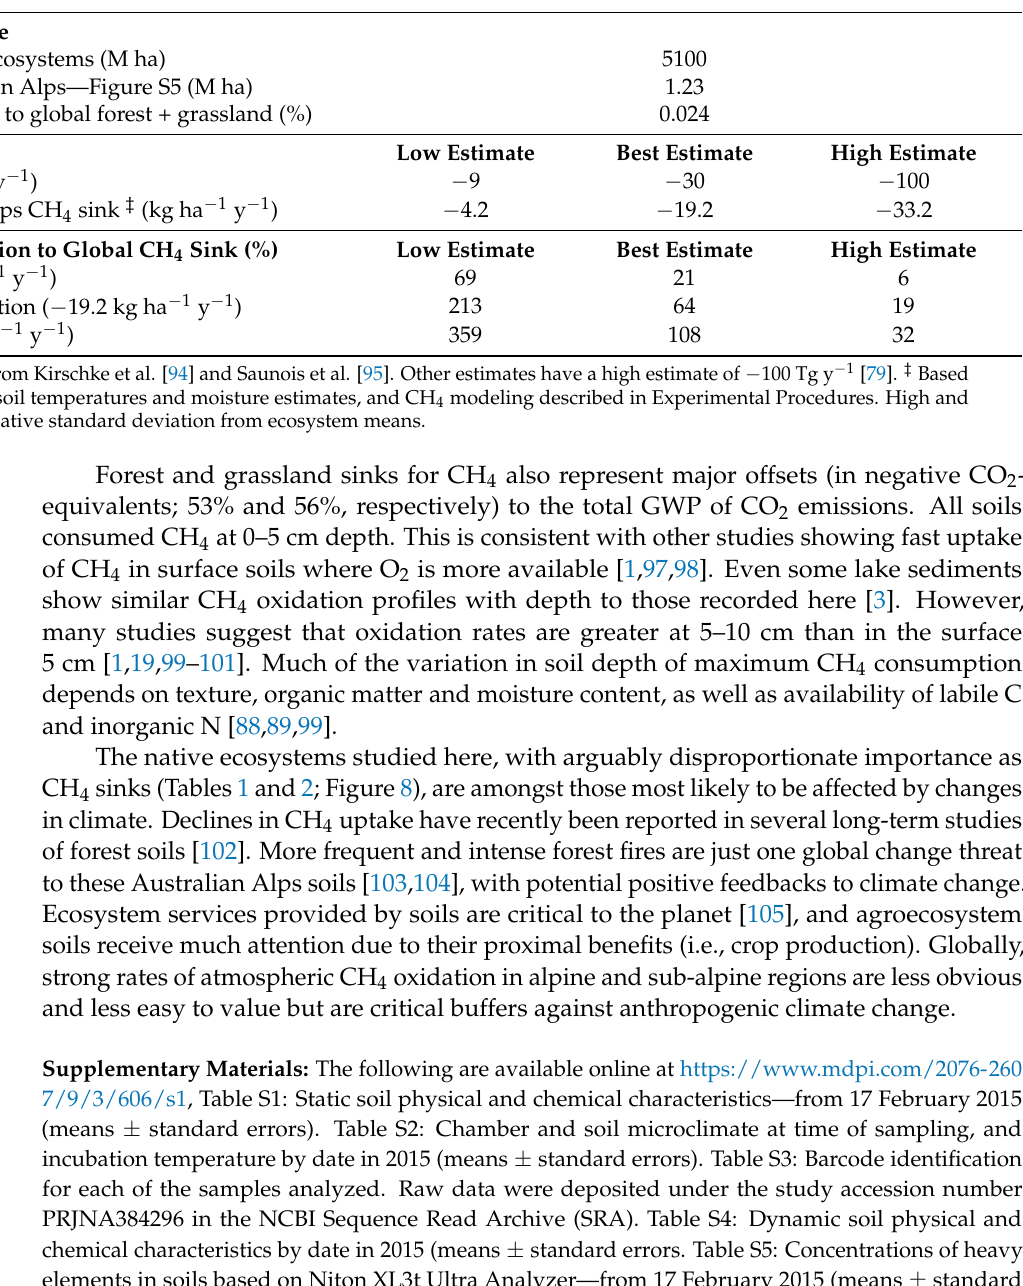
Table 2. Comparison of global and Australian Alps soil CH 4 sink estimates.